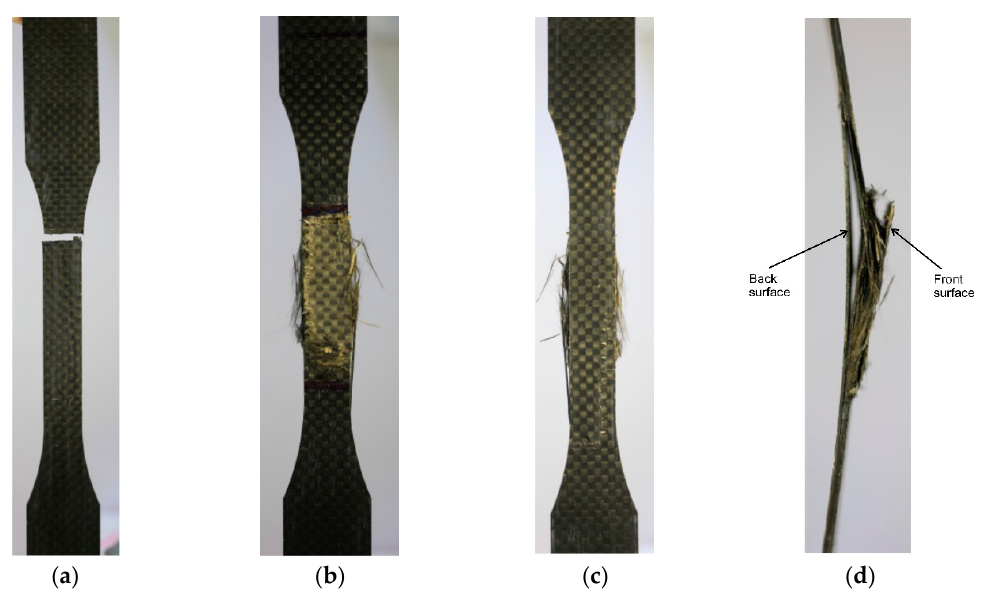
Figure 5. Results of two tensile-failure modes for CFRP specimens. ( a ) L (lateral) failure mode; ( b ) D (edge delamination) failure mode—front surface; ( c ) D failure mode—back surface; ( d ) D failure modes—side view.